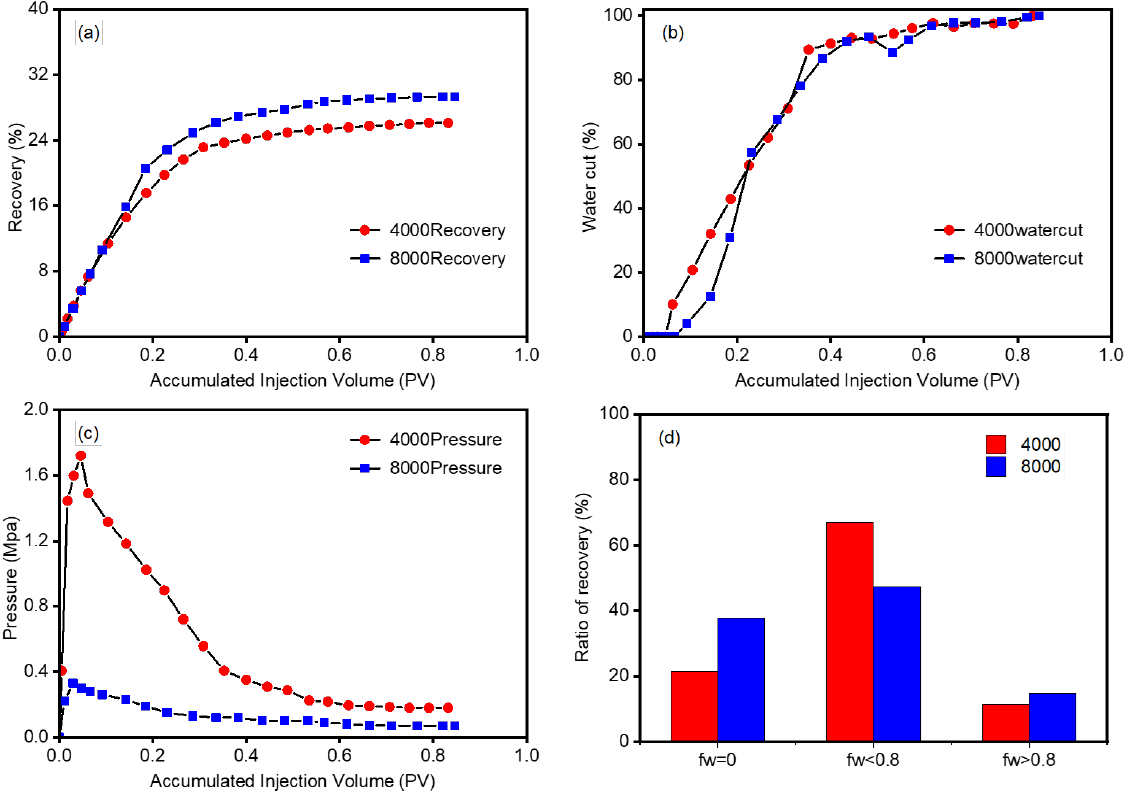
Figure 5. Recovery, water cut and pressure curves of different permeability cores. ( a ) Recovery, ( b ) water cut, ( c ) pressure, ( d ) ratio of recovery.